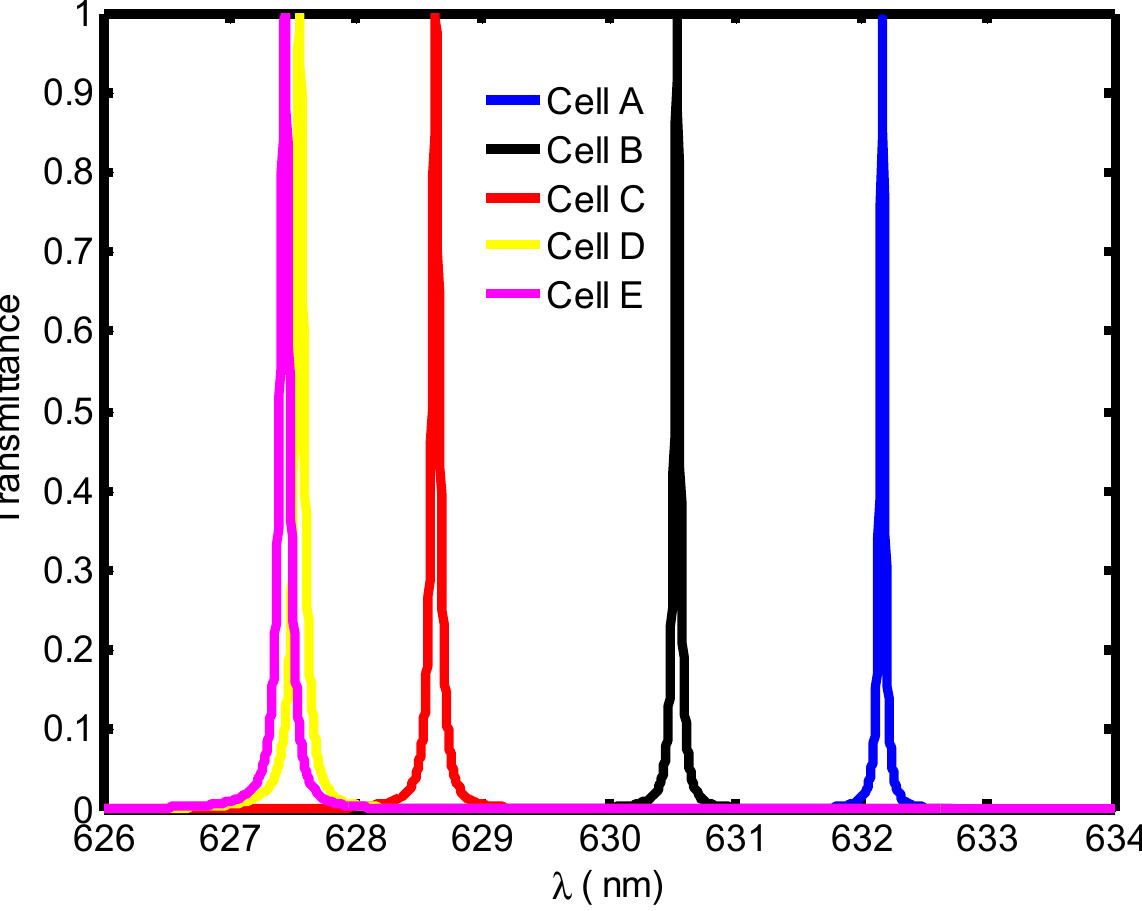
Figure 5. Transmission spectra showing five defect modes in solid blue, black, brown, yellow and purple line colors corresponding to RBC sample containing A, B, C, D and E blood cells separately, one at a time. The thickness of cavity layer is dd = 1000 nm under normal incidence.